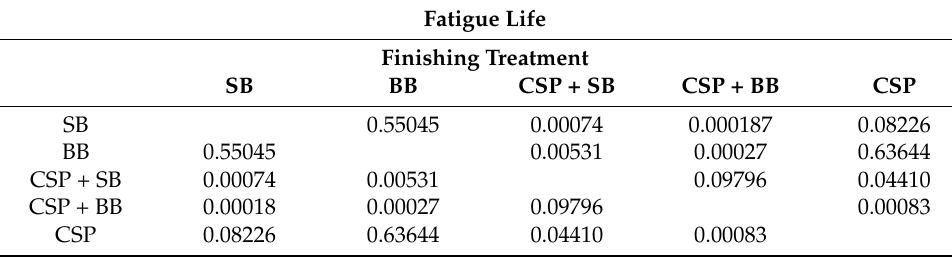
Table 6. Comparative analysis of the significance of differences (post-hoc/Tukey’s test) between the mean values of the fatigue life after treatment with different methods. The red color indicates the probability level for which there are statistically significant probability level for which there are statistically significant differences.